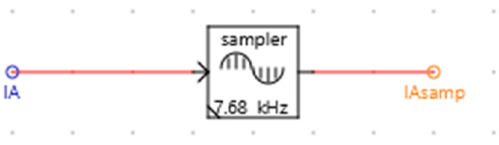
Figure 12. Sampling of the parameters.